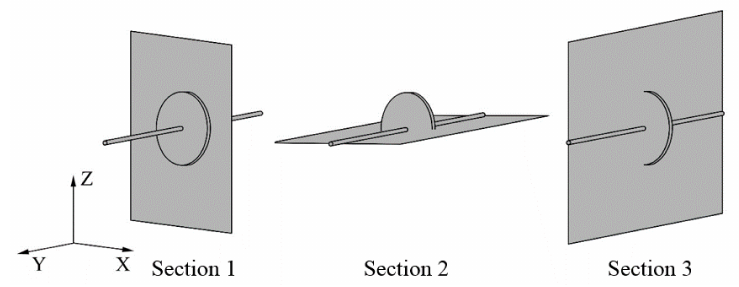
Figure 10. Illustration of the three cross-sections used in the analysis.